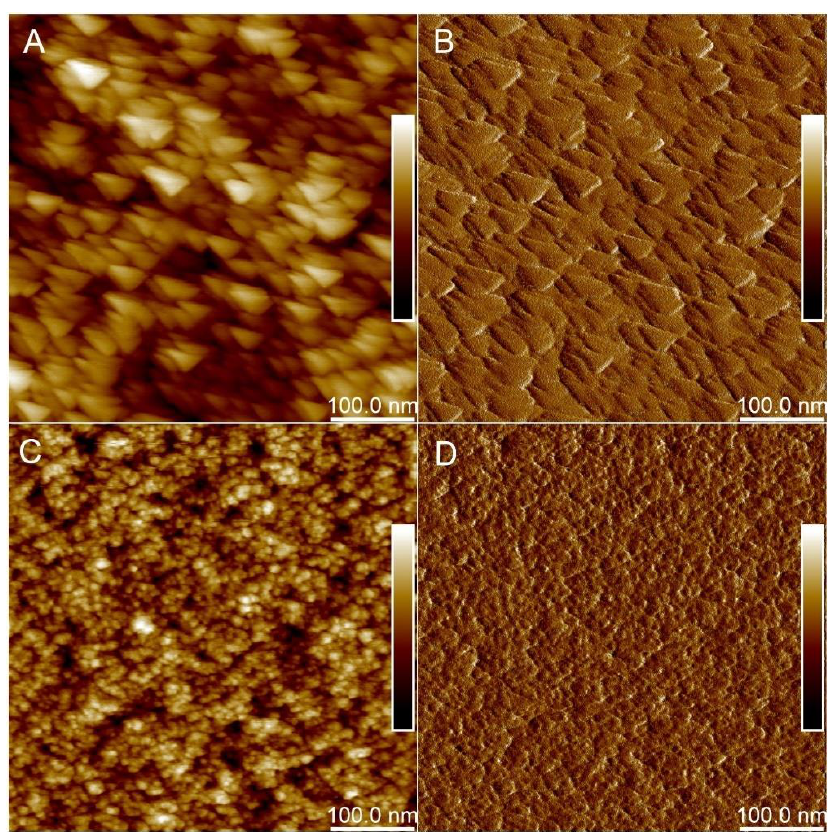
Figure 5. AFM micrographs of silica composites: ( A ) X1 in HS mode (with both β -galactosidase and PDMS); ( B ) X1 in PFE mode; ( C ) X2 in HS mode (with β -galactosidase and without PDMS); ( D ) X2 in PFE mode (with β -galactosidase and without PDMS). Dark colors indicate depressions and light color protrusions.